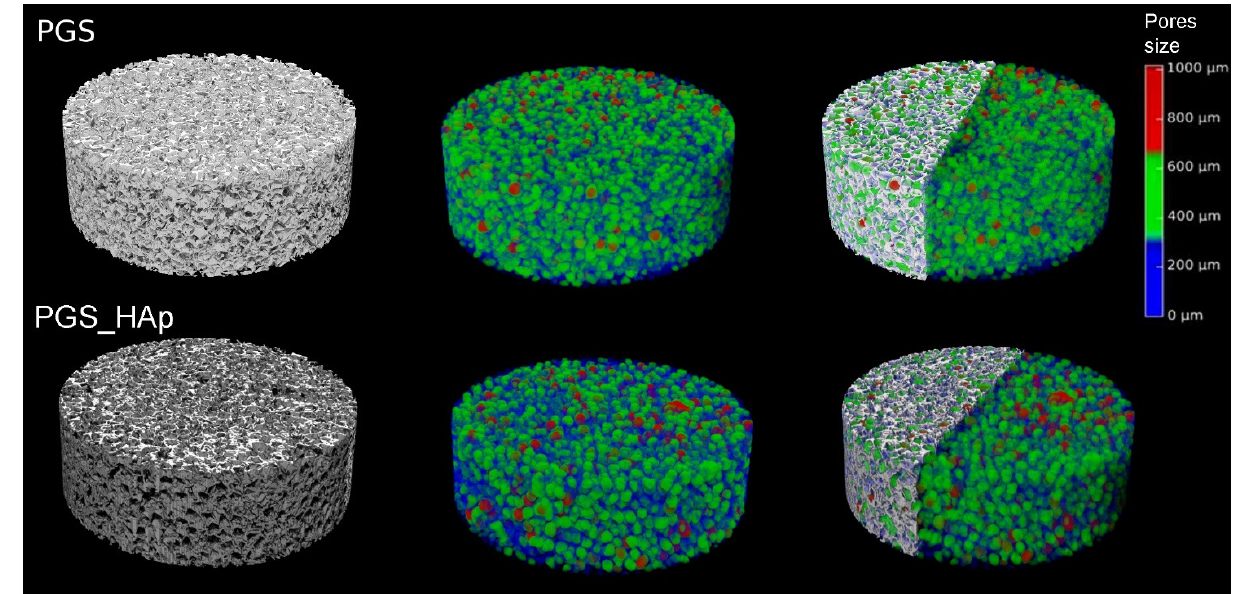
Figure 4. Reconstruction of foam structures and color-coded pore size representation. Grey colors represent the scaffold wall structure, while blue, green and red colors represent pores with different diameters. Diameters from the range 0–300 µm are blue, 300–650 µm—green and more than 650 µm—red.